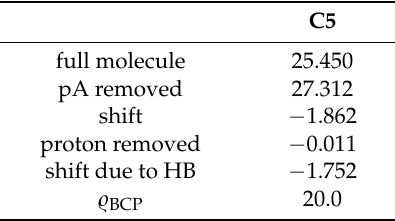
Table 2. NMR isotropic shielding (ppm) of C5 dipeptide conformation shown in Figure 3, along with density at bond critical point ( (cid:36) BCP ), in 10 − 3 au.